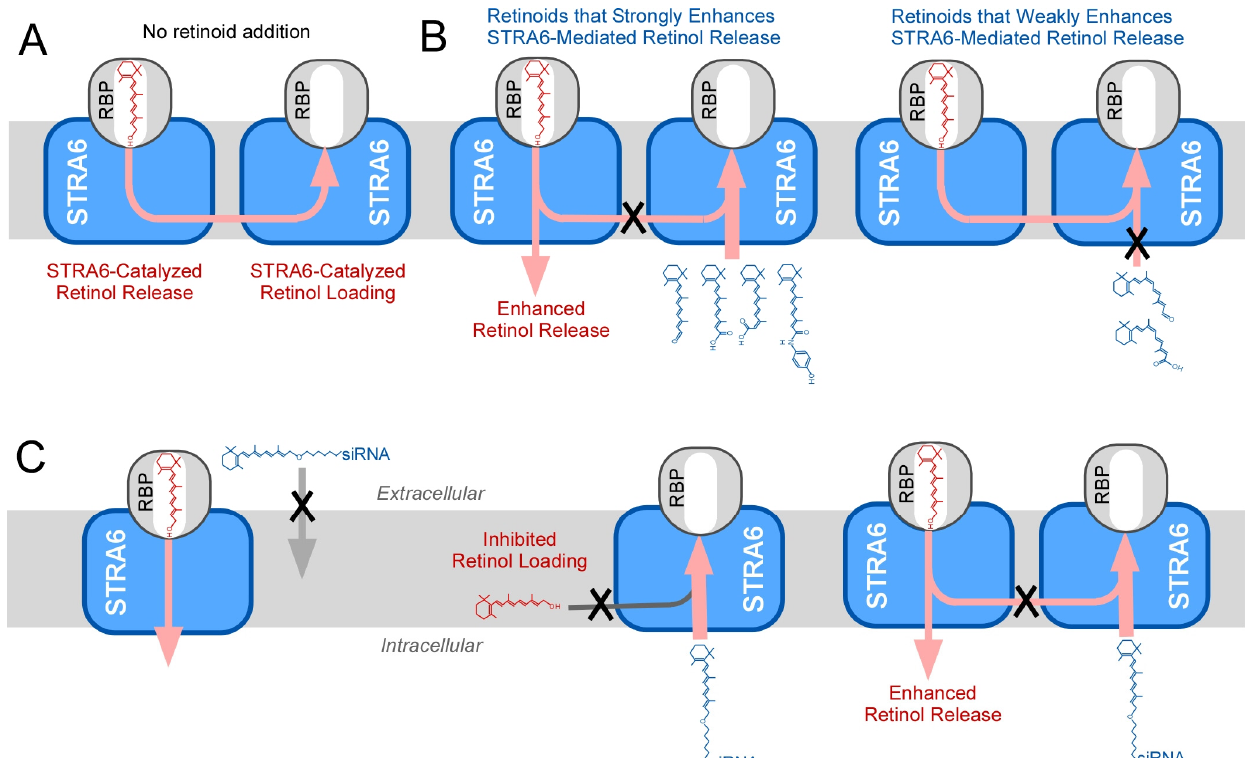
Figure 6. Schematic diagrams of the effects of retinoids on STRA6’s activities. A. The key activities of STRA6 are to catalyze retinol loading into apo-RBP and retinol release from holo-RBP. B. Fenretinide, all-trans retinal, all-trans retinoic acid and 13-cis retinoic acid more effectively stimulates STRA6-mediated retinol release and inhibits STRA6-mediated retinol loading than 9-cis retinol, 9-cis retinal and 9-cis retinoic acid. C. Schematic